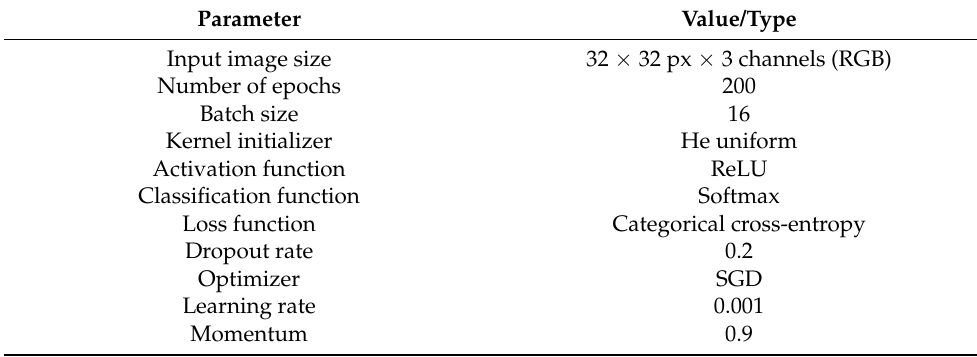
Table 1. Parameters of the proposed CNN-based models.